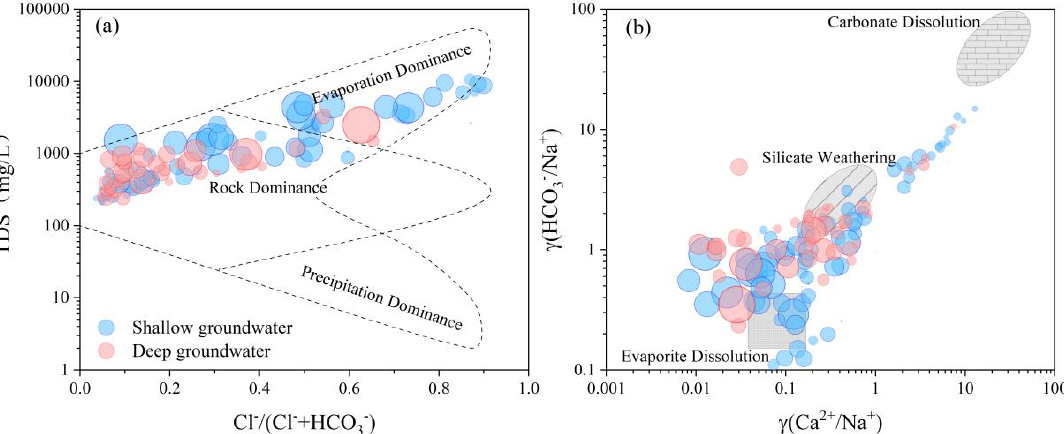
Figure 5. ( a ) Na + /(Na + + Ca 2+ ) mg/L vs. Log TDS with fluoride concentrations indicated as bubbles; ( b ) Na-normalized HCO 3 − vs. Na-normalized Ca 2+ (mM/mM) with fluoride concentrations indicated as bubbles.